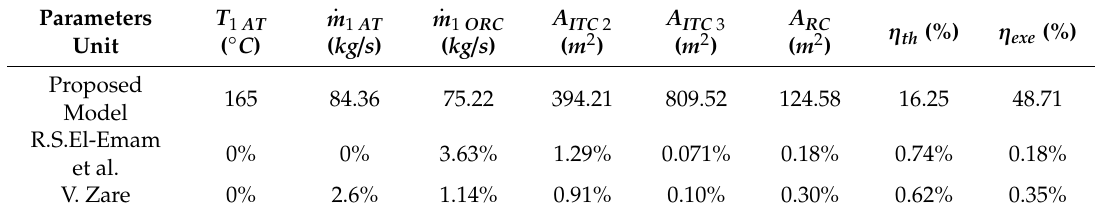
Table 1. Absolute error of RORC model with respect to R. S. El-Emam et al. [31] and V. Zare [32].